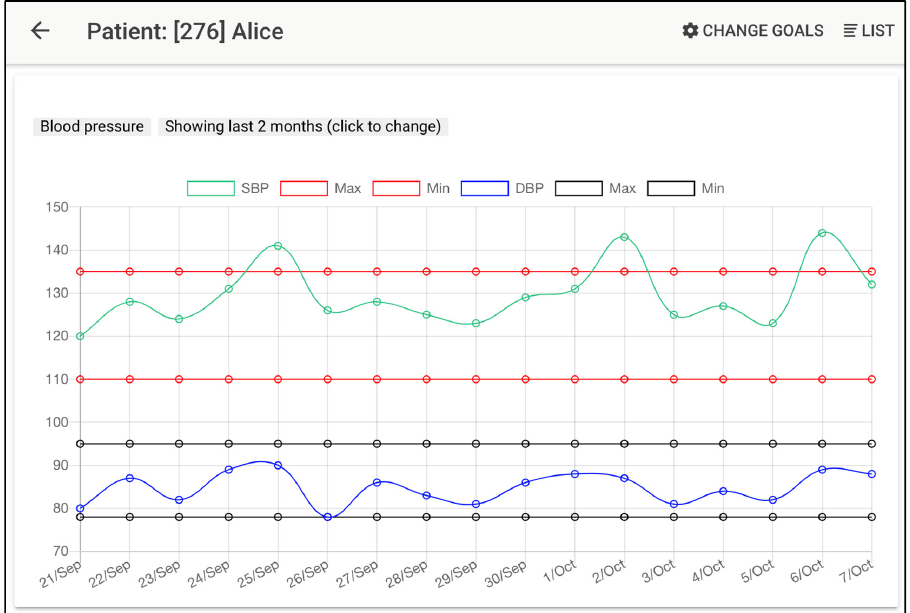
Figure 3. TeleHealth system: professional’s view (control panel). Available as Supplementary Material for better visualization, together with additional screenshots.